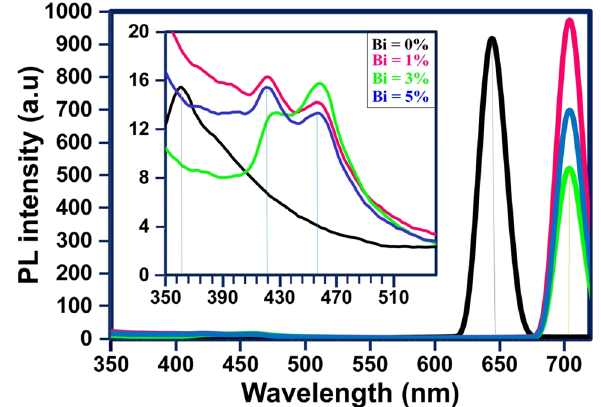
Zn Bi S QDs with respect to 0.9-x 0.1 x